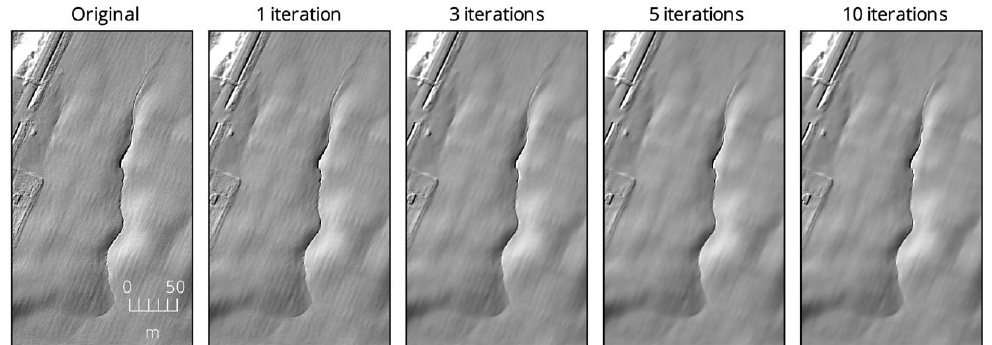
Figure 7. The effects of altering the number of elevation update iterations in the FPDEMS. Each smoothing operation was run with a 15 × 15 filter size and a threshold angle of 15 ◦ . Images present portions of the shaded relief images extracted from each DEM.